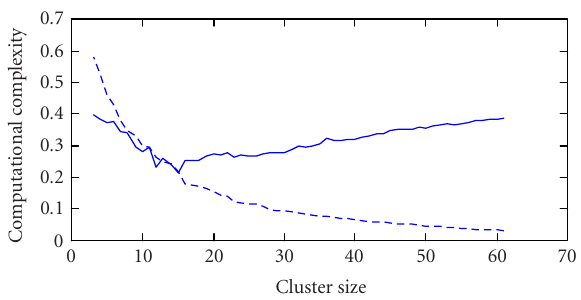
Figure 8: The solid line plots risk and the dashed line plots relative computational complexity versus cluster size of our system. Num- ber of speakers = 62.